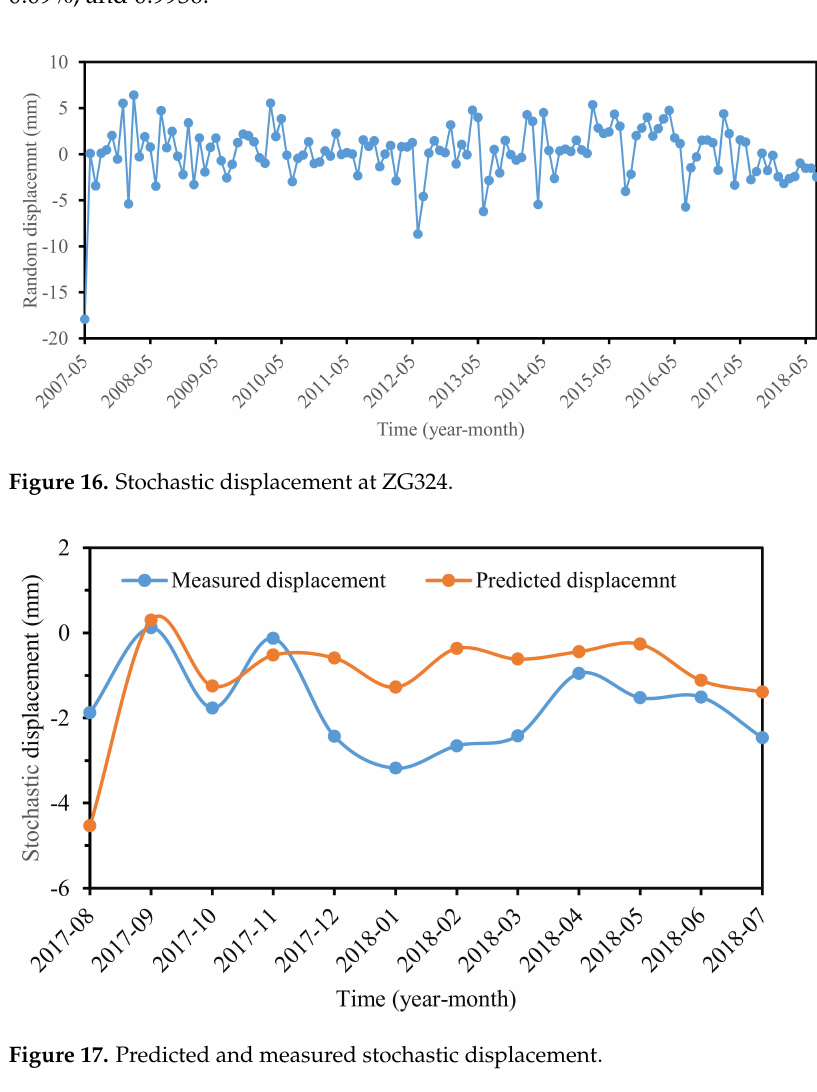
Figure 17. Predicted and measured stochastic displacement.